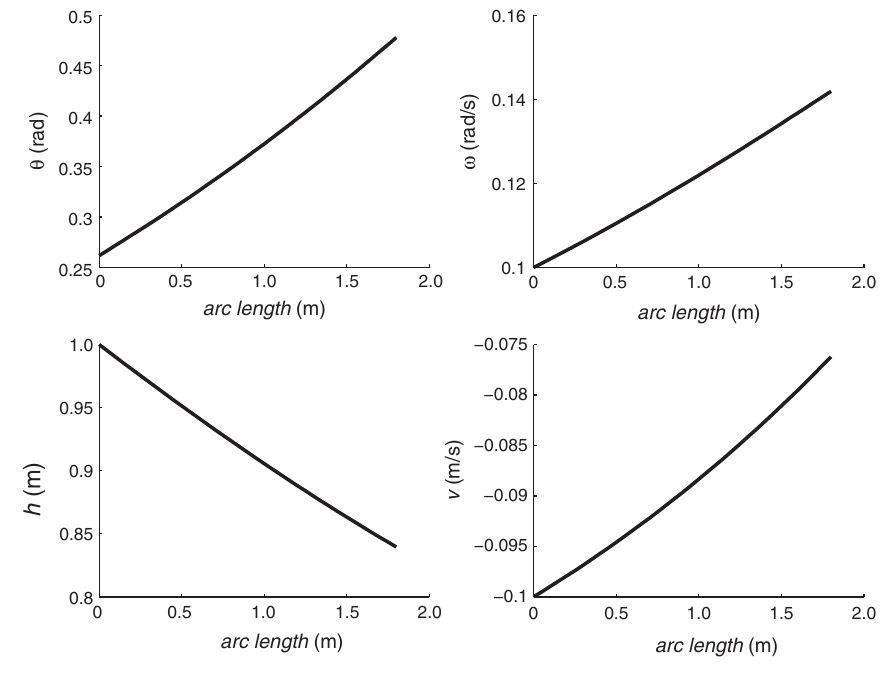
Fig. 3. Geodesic gait from state 0 to state